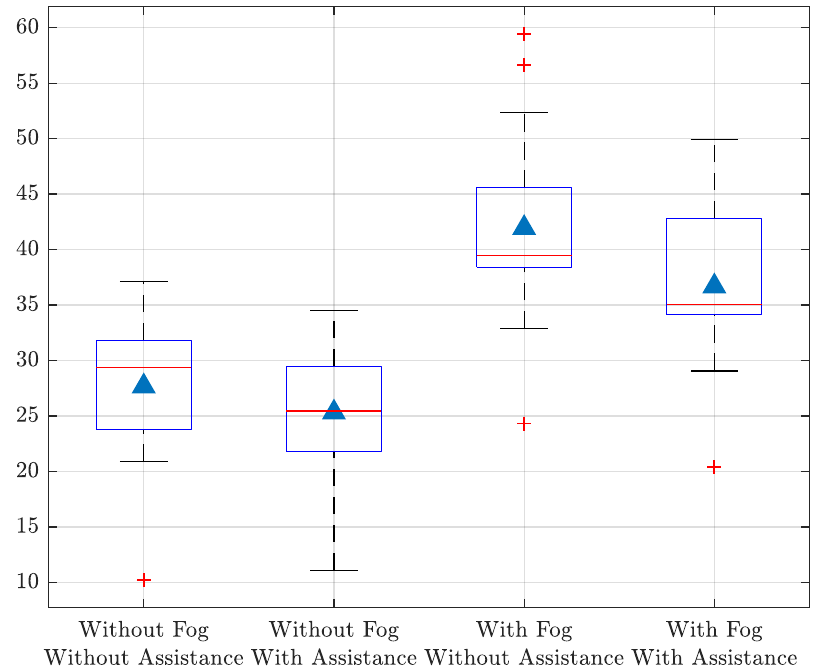
Figure 6. SWRR per minute with a gap size of 2 ◦